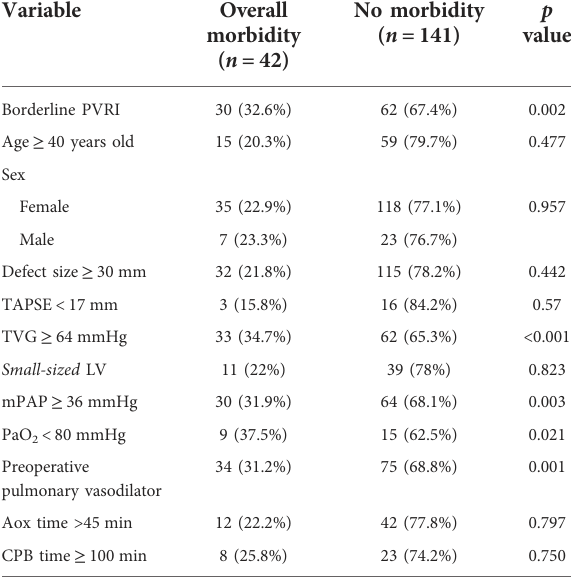
TABLE 5 Univariate and bivariate analysis factors in fl uencing overall morbidity.